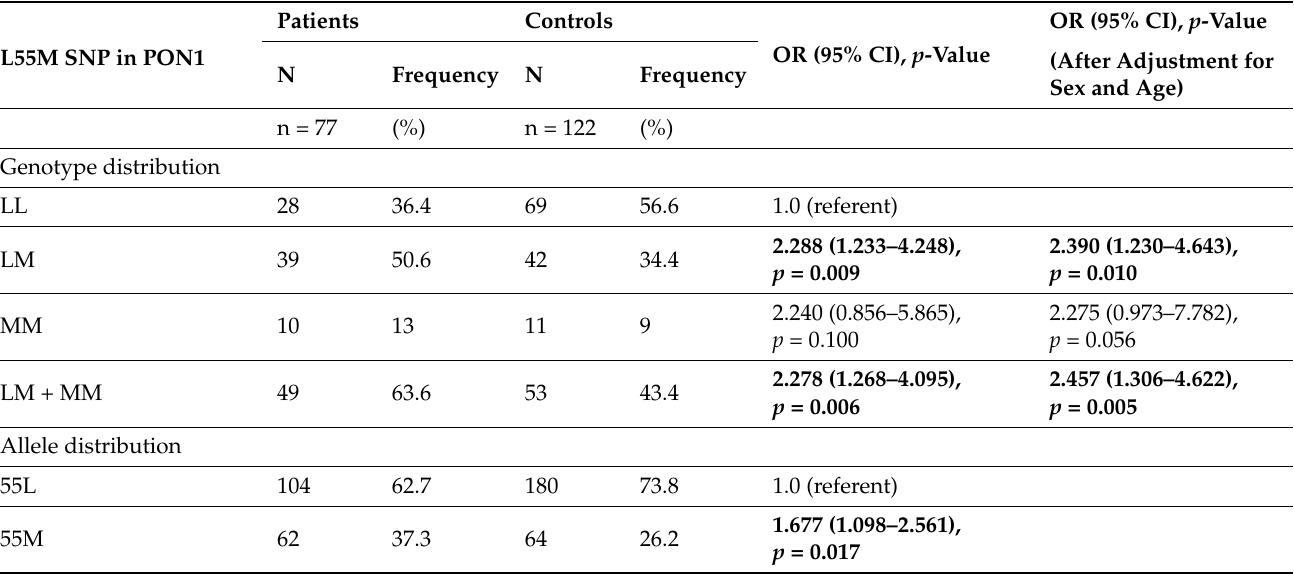
Table 3. Genotype and allelic distribution of L55M in PON1 in patients with acute coronary syndrome and